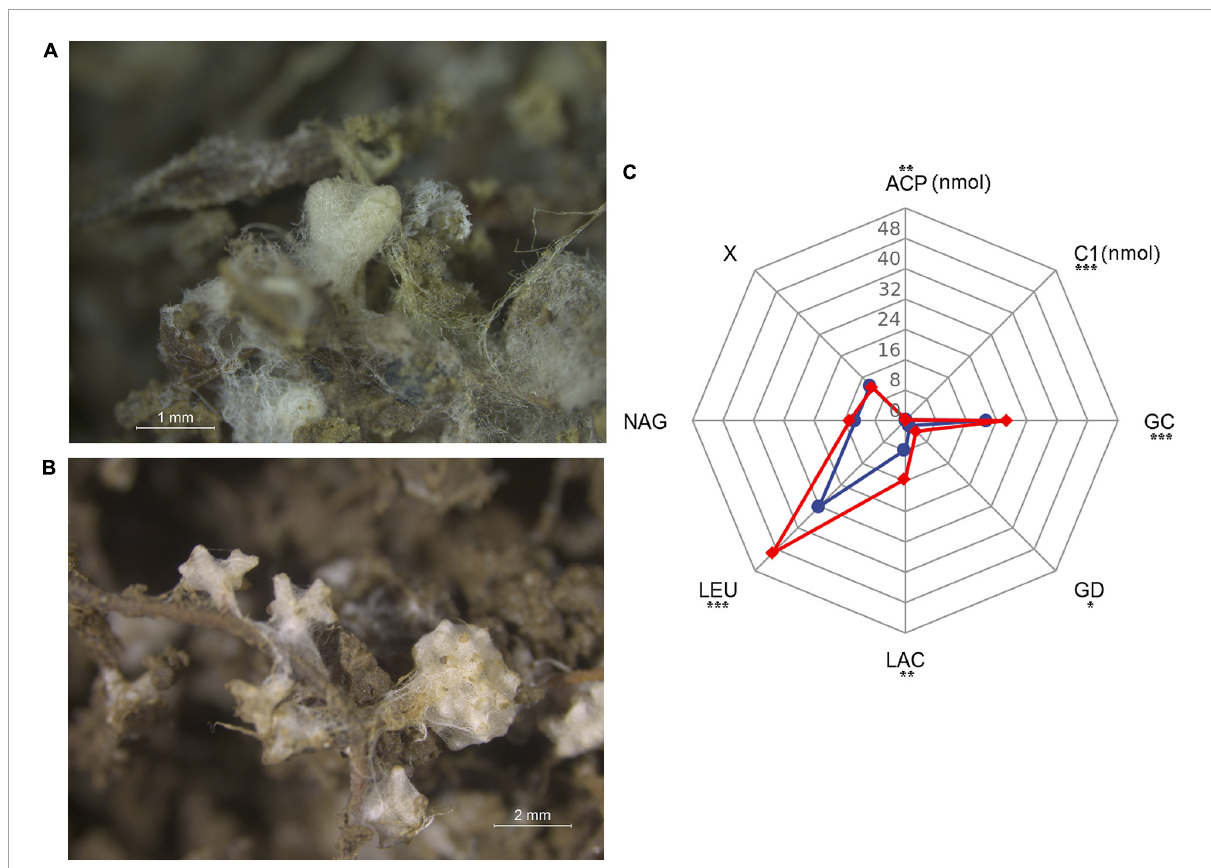
FIGURE5 Bioassay experiment in greenhouse. (A) Mycorrhizal root tips of Pinus radiata (PR). (B) Mycorrhizal root tips of Pinus massoniana (PM). (C) Enzyme activity (pmol tip − 1 min − 1 /C1 and ACP: nmol tip − 1 min − 1 ) profiles of mycorrhizal root tips. PR seedlings-red line, PM seedlings-blue line. C1, cellobiohydrolase; GC, β -glucosidase; GD, β -glucuronidase; LAC, laccase; X, β -xylosidase; LEU, leucine aminopeptidase; NAG, N -acetylglucosaminidase; ACP, acid phosphatase. * P < 0.05; ** P < 0.01; *** P <